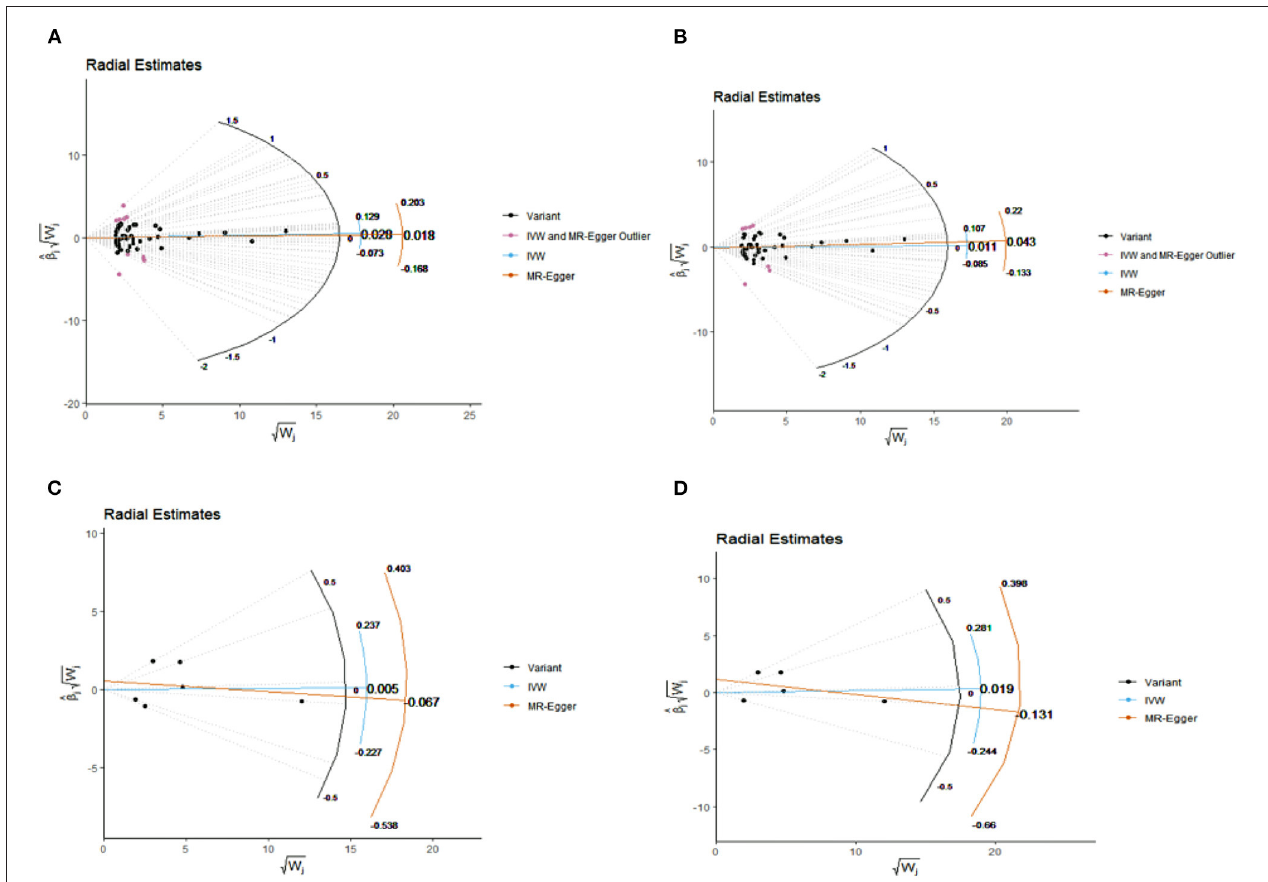
FIGURE 3 | Radial plots to visualize individual outlier single nucleotide polymorphisms (SNPs) in the Mendelian randomization (MR) estimates for association between vitamin D with AF by model 1 (A) and model 2 (B) or association between 25-hydroxyvitamin D with AF by model 1 (C) and model 2 (D) . Black dots show valid SNPs and purple dots display invalid outlier SNPs. There is no significant outlier SNP in present plots C and D. IVW, indicates inverse-variance weighted.